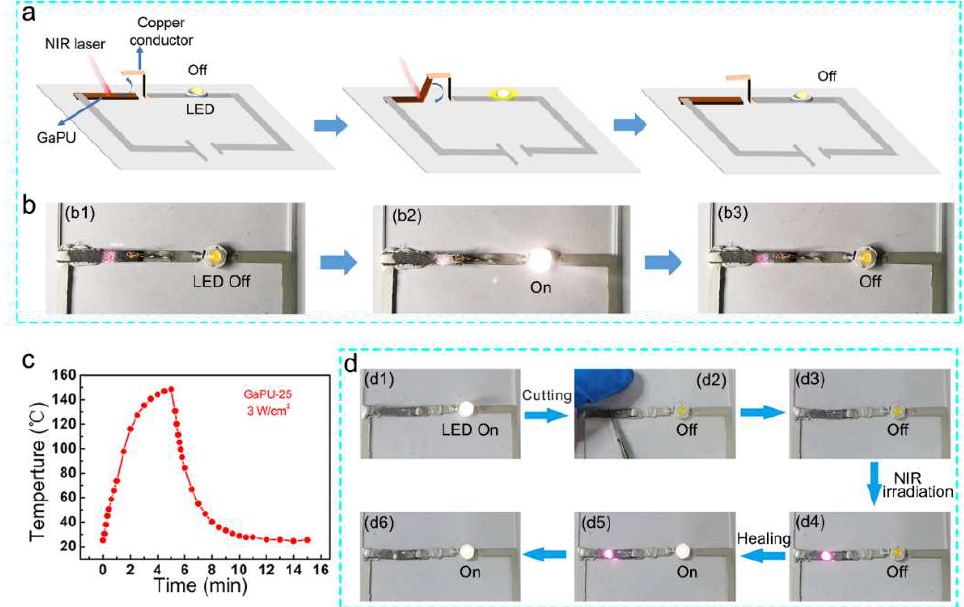
Figure 5. Light-controlled and self-healing LED circuits enabled by Ga–PU composites. ( a ) Schematic illustrations showing a light-controlled switch made of the composite for an electric circuit. ( b ) An LED circuit is remotely controlled by the composite switch (20 vol% Ga) under NIR light irradiation. ( c ) The temperature as a function of time for the composite with 25 vol% Ga under NIR irradiation (3 W/cm 2 ). ( d ) Photographs demonstrating the self-healing LED circuit with the composite (25 vol% Ga) as conductor; the composite is severed by a knife and healed by irradiating the break with NIR light.